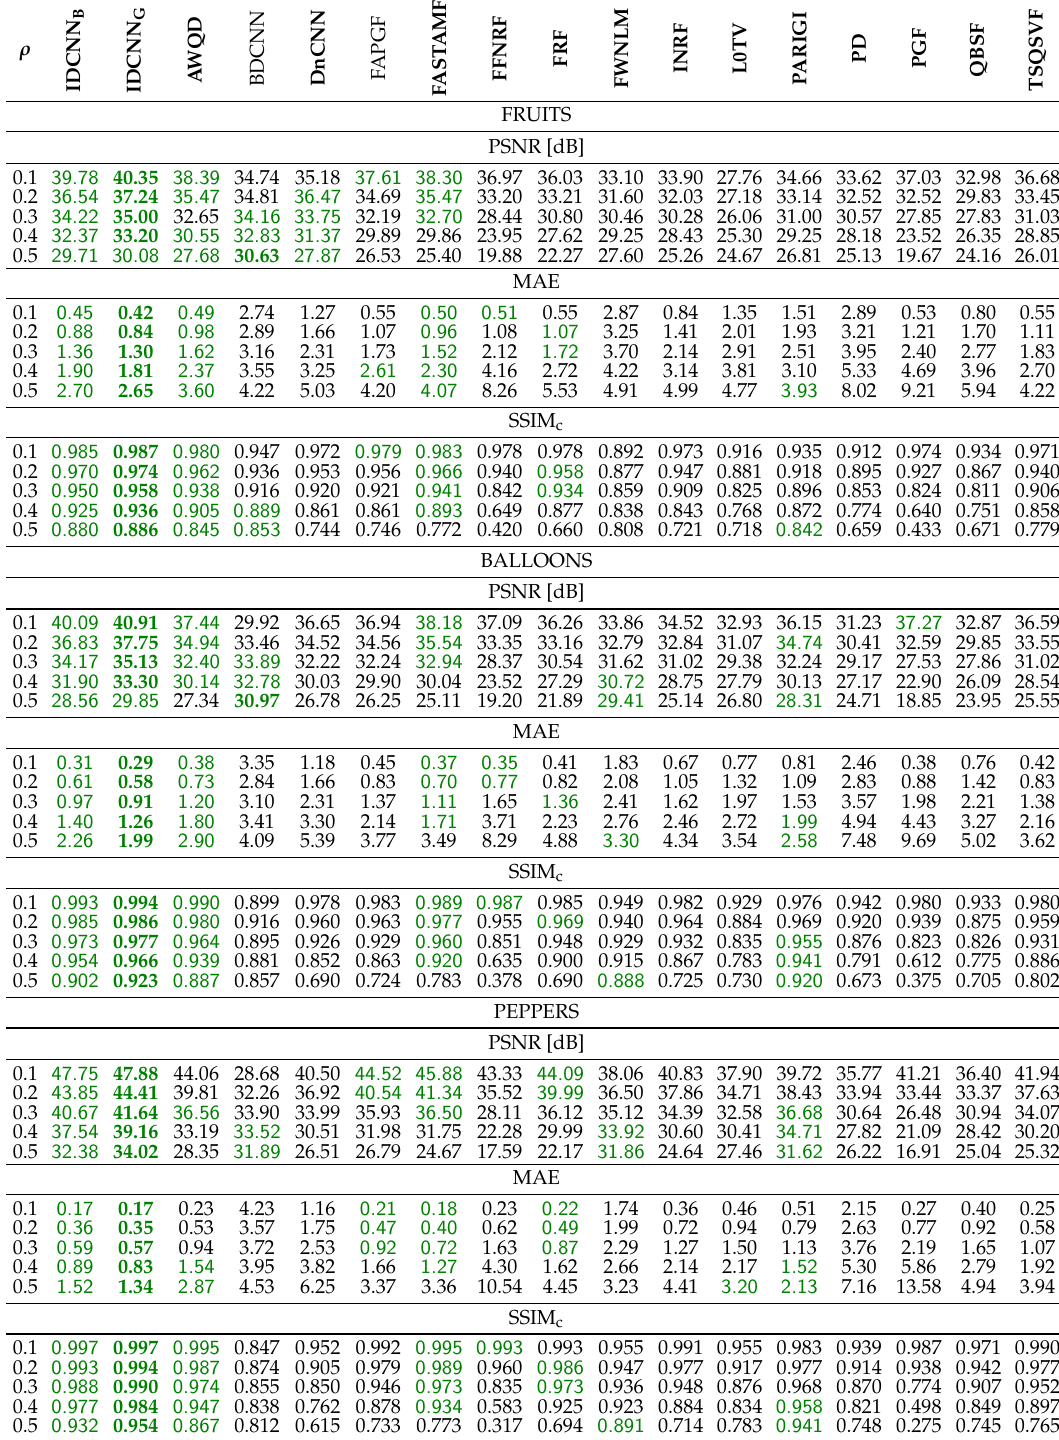
Table 6. Comparison of the denoising efficiency of the proposed network for impulsive noise removal with the state-of-the-art methods on selected representative images from the test dataset [36]. The result obtained with the most efficient filter are emboldened and 5 best results are highlighted with green